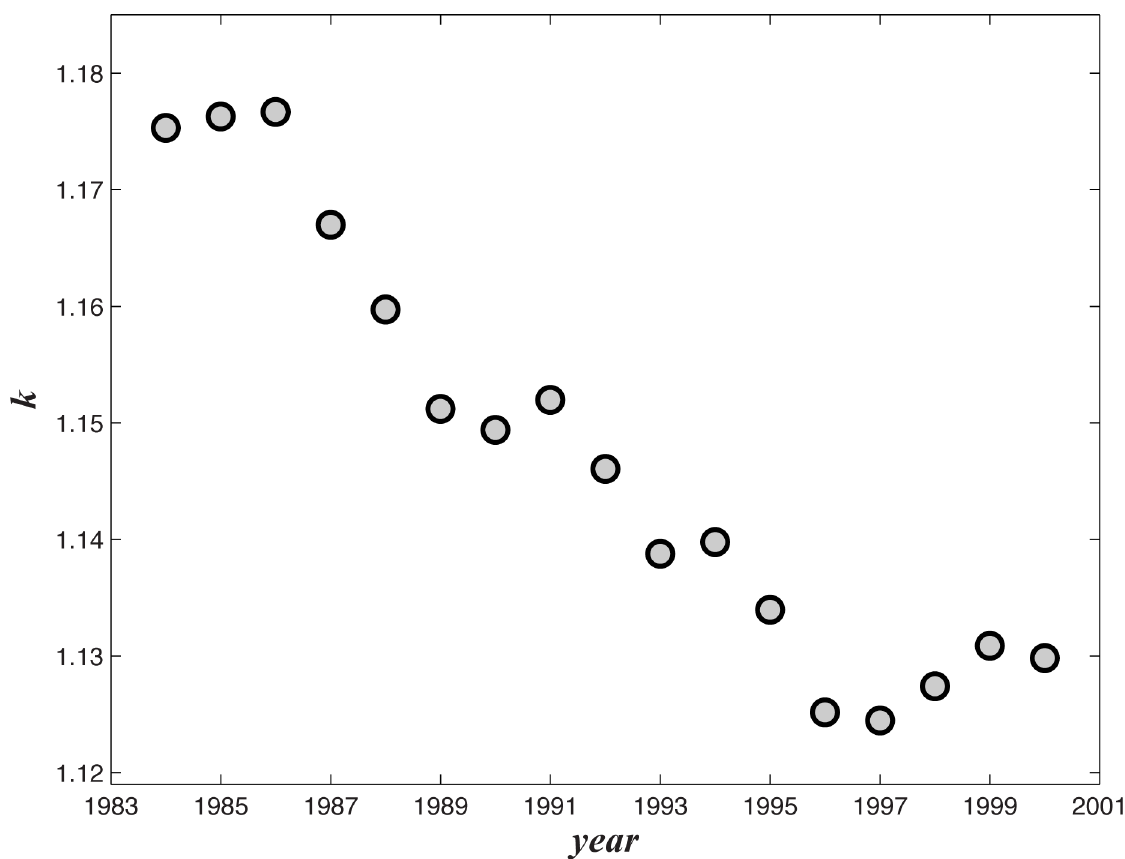
Fig 8. The variation evolution of k from 1984 to